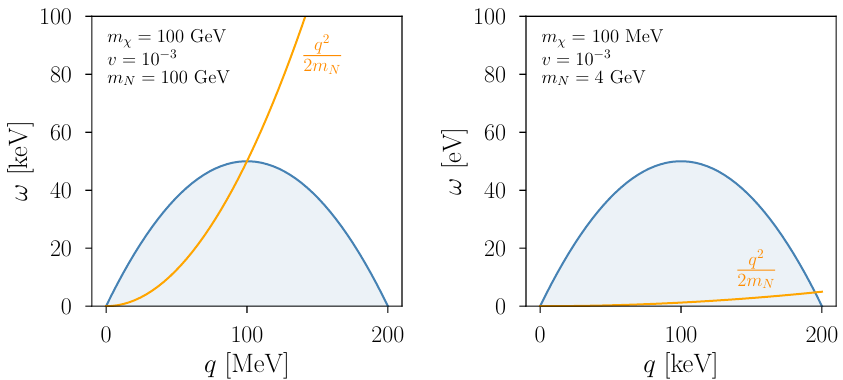
Figure 1: The blue shaded region is the kinematically allowed region for DM scat- tering with v = 10 − 3 . This region must be matched onto the allowed response of the target system, which for nuclear recoils is a resonant response at q 2 / ( 2 m m χ = m we have the optimal matching since it is possible for DM to deposit up to N all of its initial kinetic energy. When m χ (cid:28) m system only in a corner of the phase space, and the maximum recoil energy is much